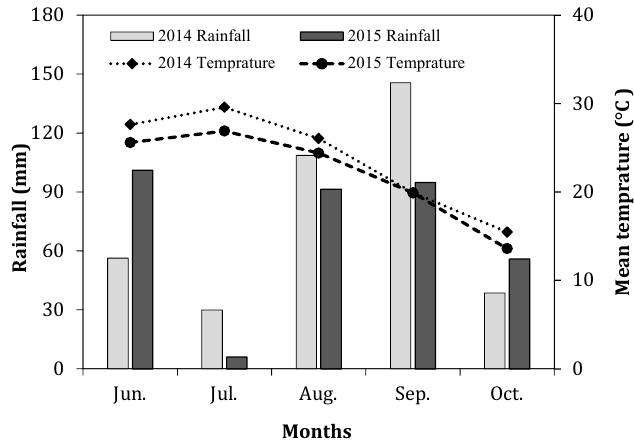
Figure 1. Mean temperature (°C) and precipitation (mm) during 2014 and 2015 maize growing seasons at the experimental site.